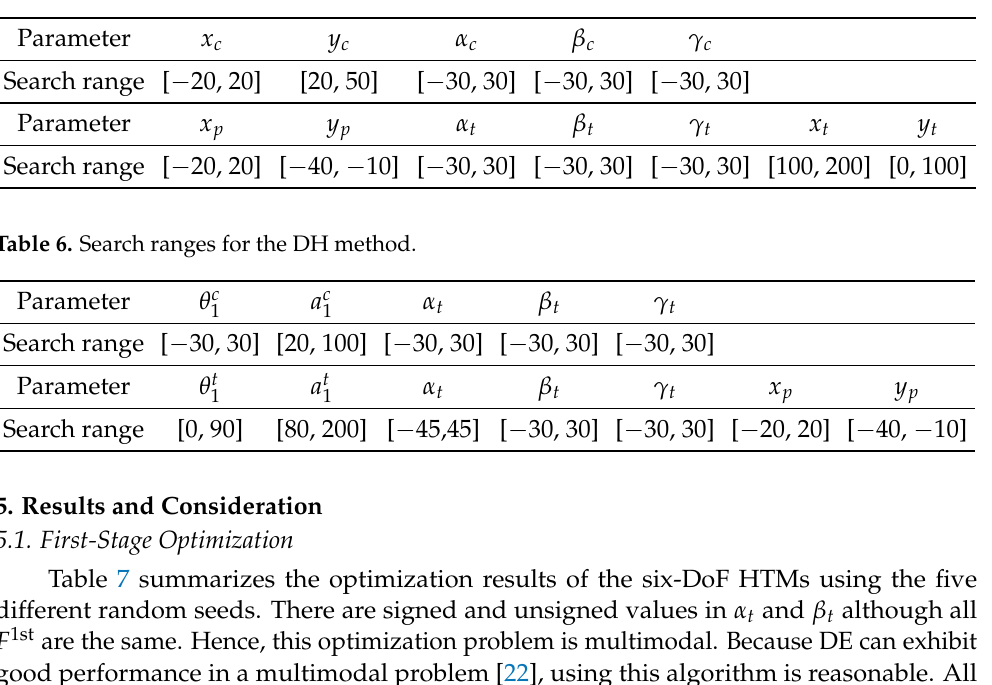
Table 5. Search ranges of optimized parameters for six-DoF HTMs.